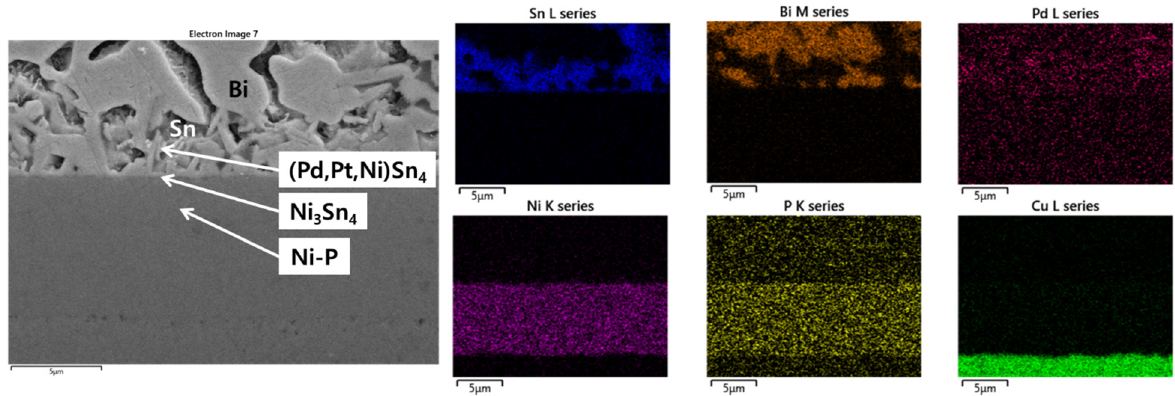
Figure 6. EDX elemental analysis of the Sn-58Bi-0.1Pt/ENEPIG interface after 200 h of aging.